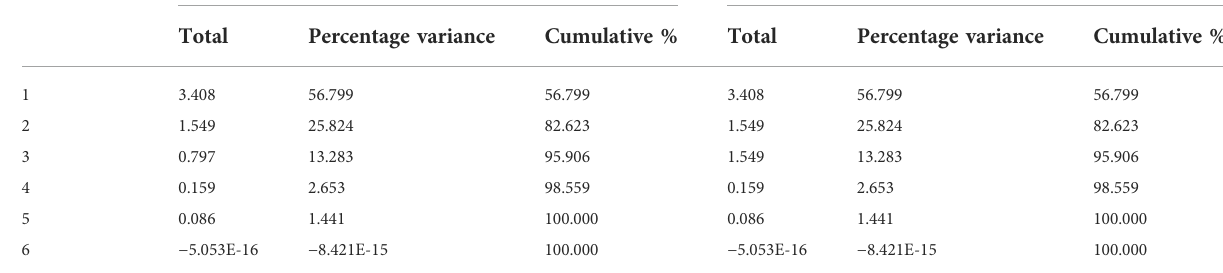
TABLE 3 Principal ingredient extraction.